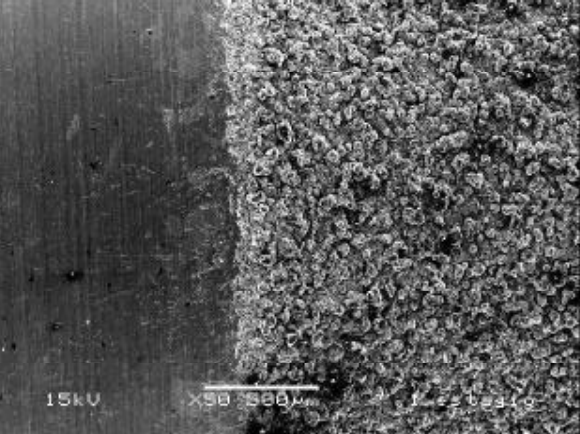
FIGURA 3- Porção rugosa e transmucoso polido nos implantes de um estágio. Observar a presença do TPS em toda porção endóssea (seta) (x50)